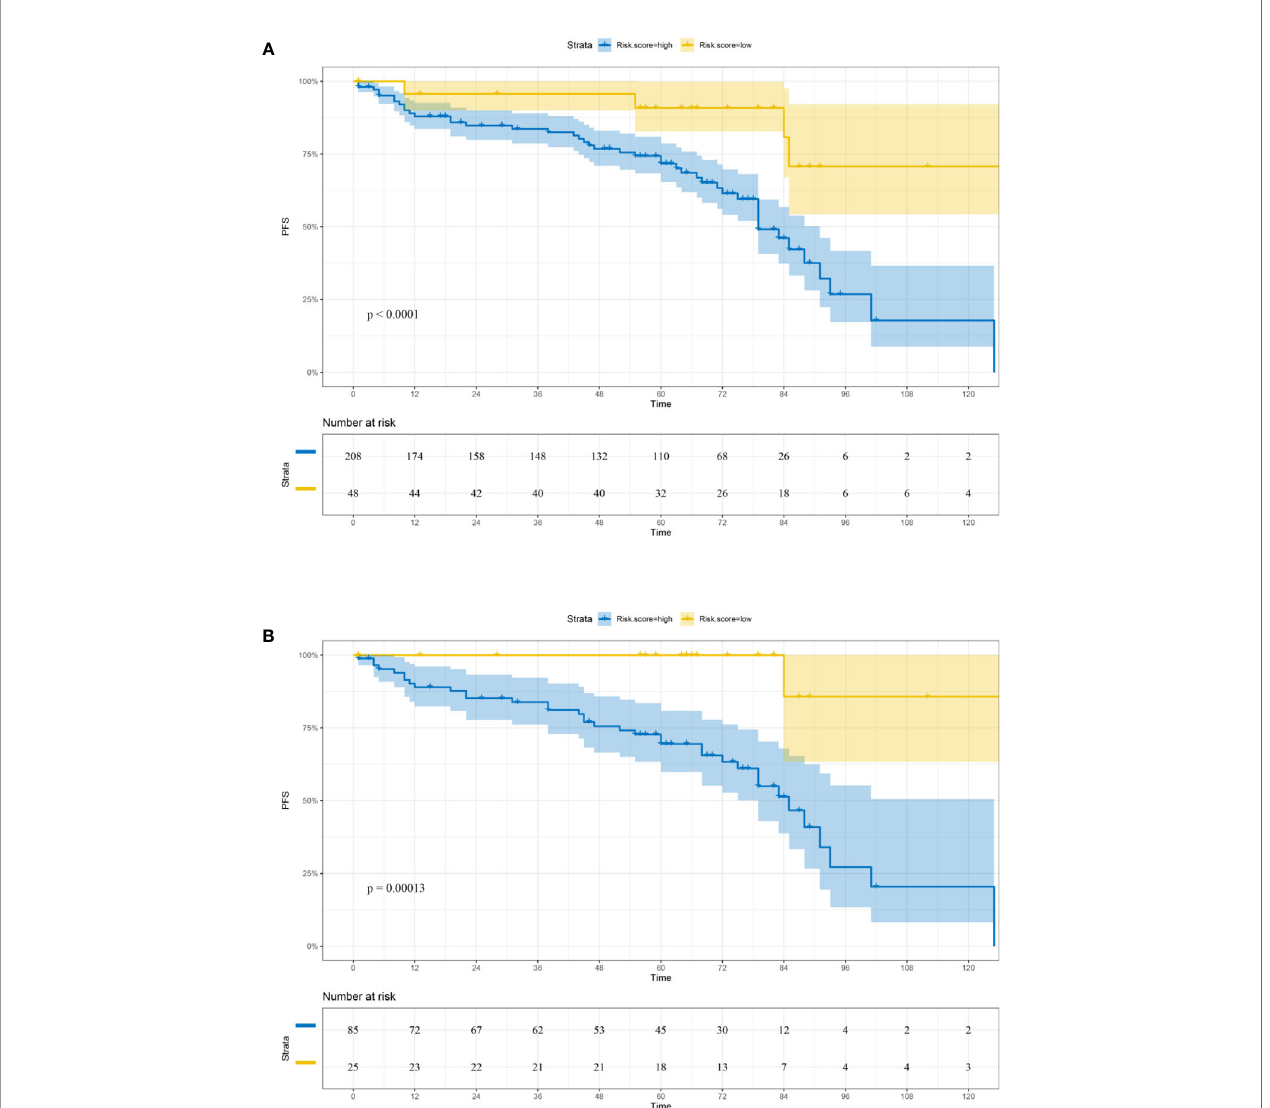
FIGURE 3 | Comparison of DFS in low-risk and high-risk groups strati fi ed by IHC signature. (A) Training cohort. (B) Validation